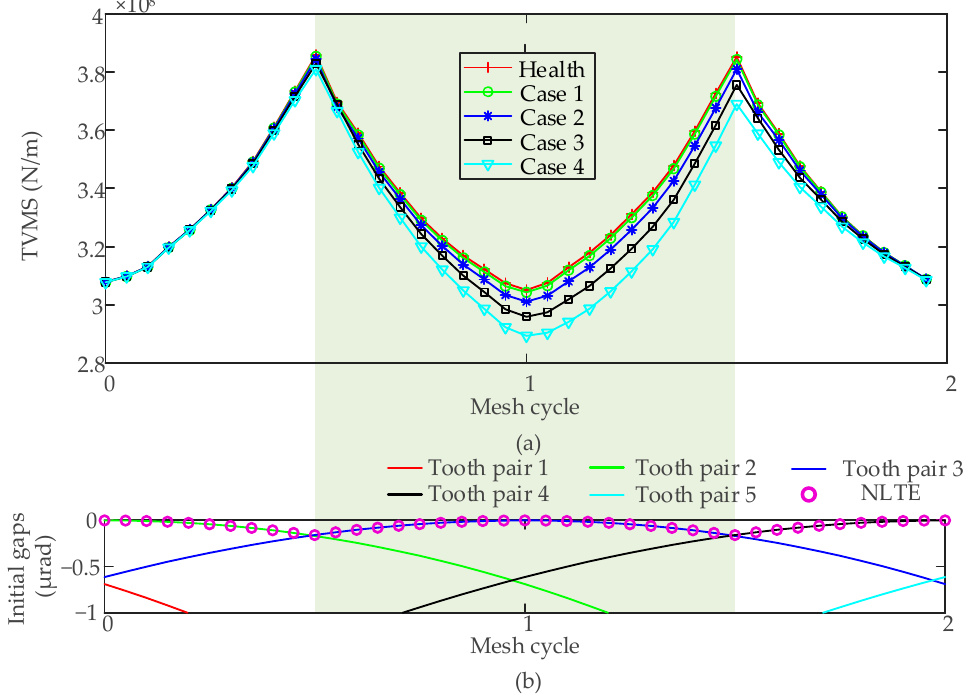
Figure 15. TVMS and the initial gaps of the SBGP: ( a ) TVMS versus different crack levels; ( b ) The initial gaps during two meshing cycles.